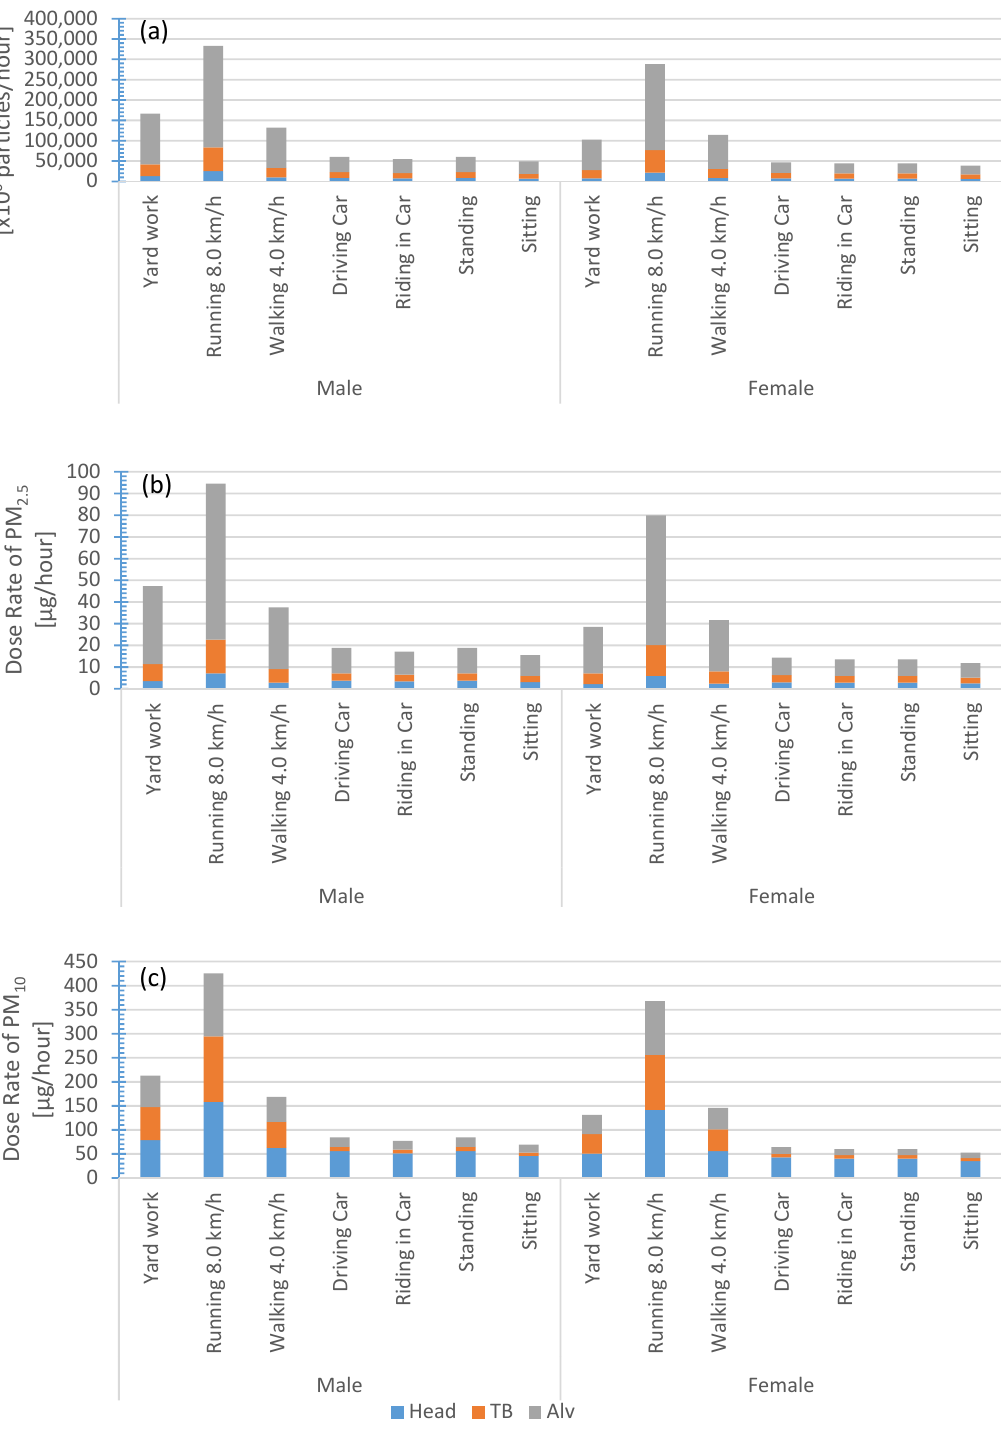
Figure 6. Main roads of Amman; regional inhaled deposited dose rates calculated for di ff erent activities and genders: ( a ) submicron particle number concentration and ( b , c ) particulate matter PM 2.5 and PM 10 . The color legend is: (blue) head airways, (red) tracheobronchial, and (green)